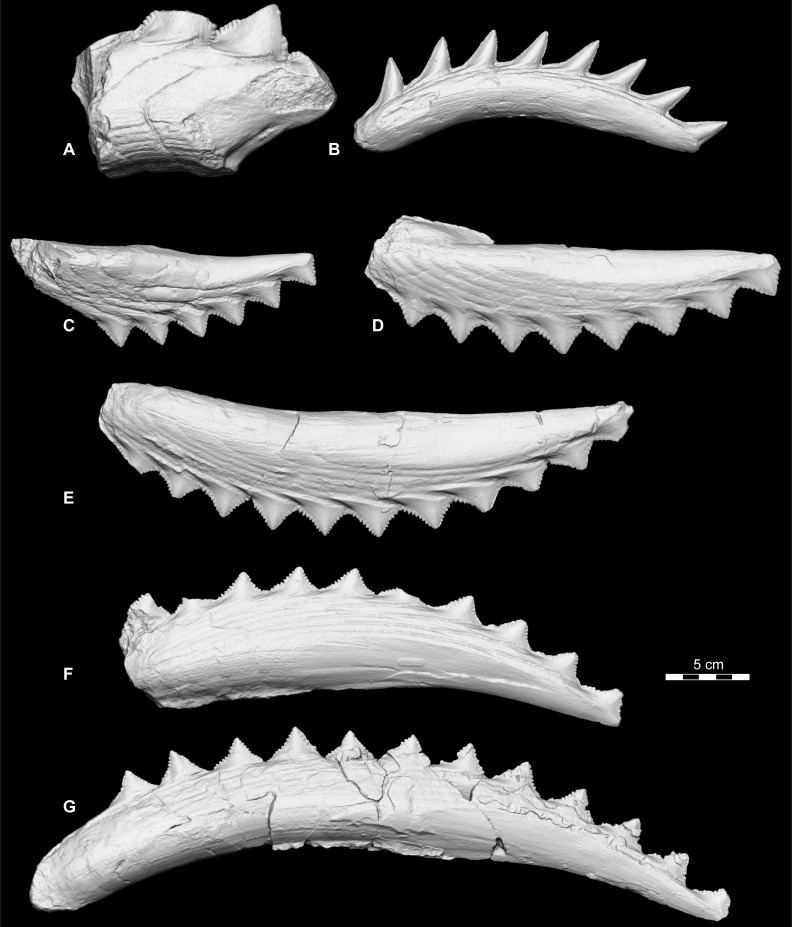
Geometric morphometrics of Edestus with asymmetric-crowned teeth.(A) PCA of all crowns color-coded by crown width size to show ontogenetic variation. Multiple crowns from holotype E. mirus from both upper and lower whorls outlined. All holotypes have black outlined circle symbol. Diamond symbol denotes specimens plotted in the upper grouping of B. (B) PC2 plotted by crown width. Light and dark grey convex hulls demark morphospace of two groups of crowns. (C) PC2 of all asymmetric crowns correlates strongly with the upper ratio metric. (D) Ratio of linear measures distinguishing two asymmetric crown types for Edestus, based on geometric ordination and groupings in B. (E) Discriminant analysis of asymmetric crown using linear measurements classified by groupings shown in B and D. Holotype specimens of E. triserratus, E. minusculus, and E. kolomnensis form the upper group (pink); Holotypes of E. mirus (multiple crowns), E. pringlei, and E. minor form lower group (blue). Loadings for linear measurements (see Fig 1) on the discriminant axis.